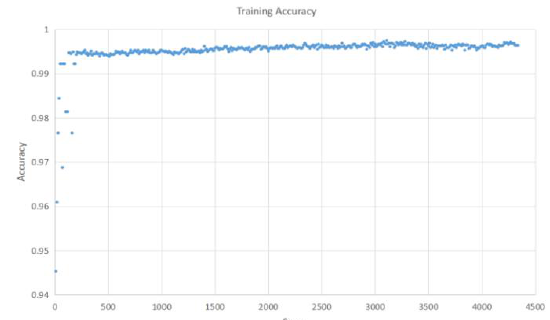
Figure 5. Training accuracy of the proposed model.